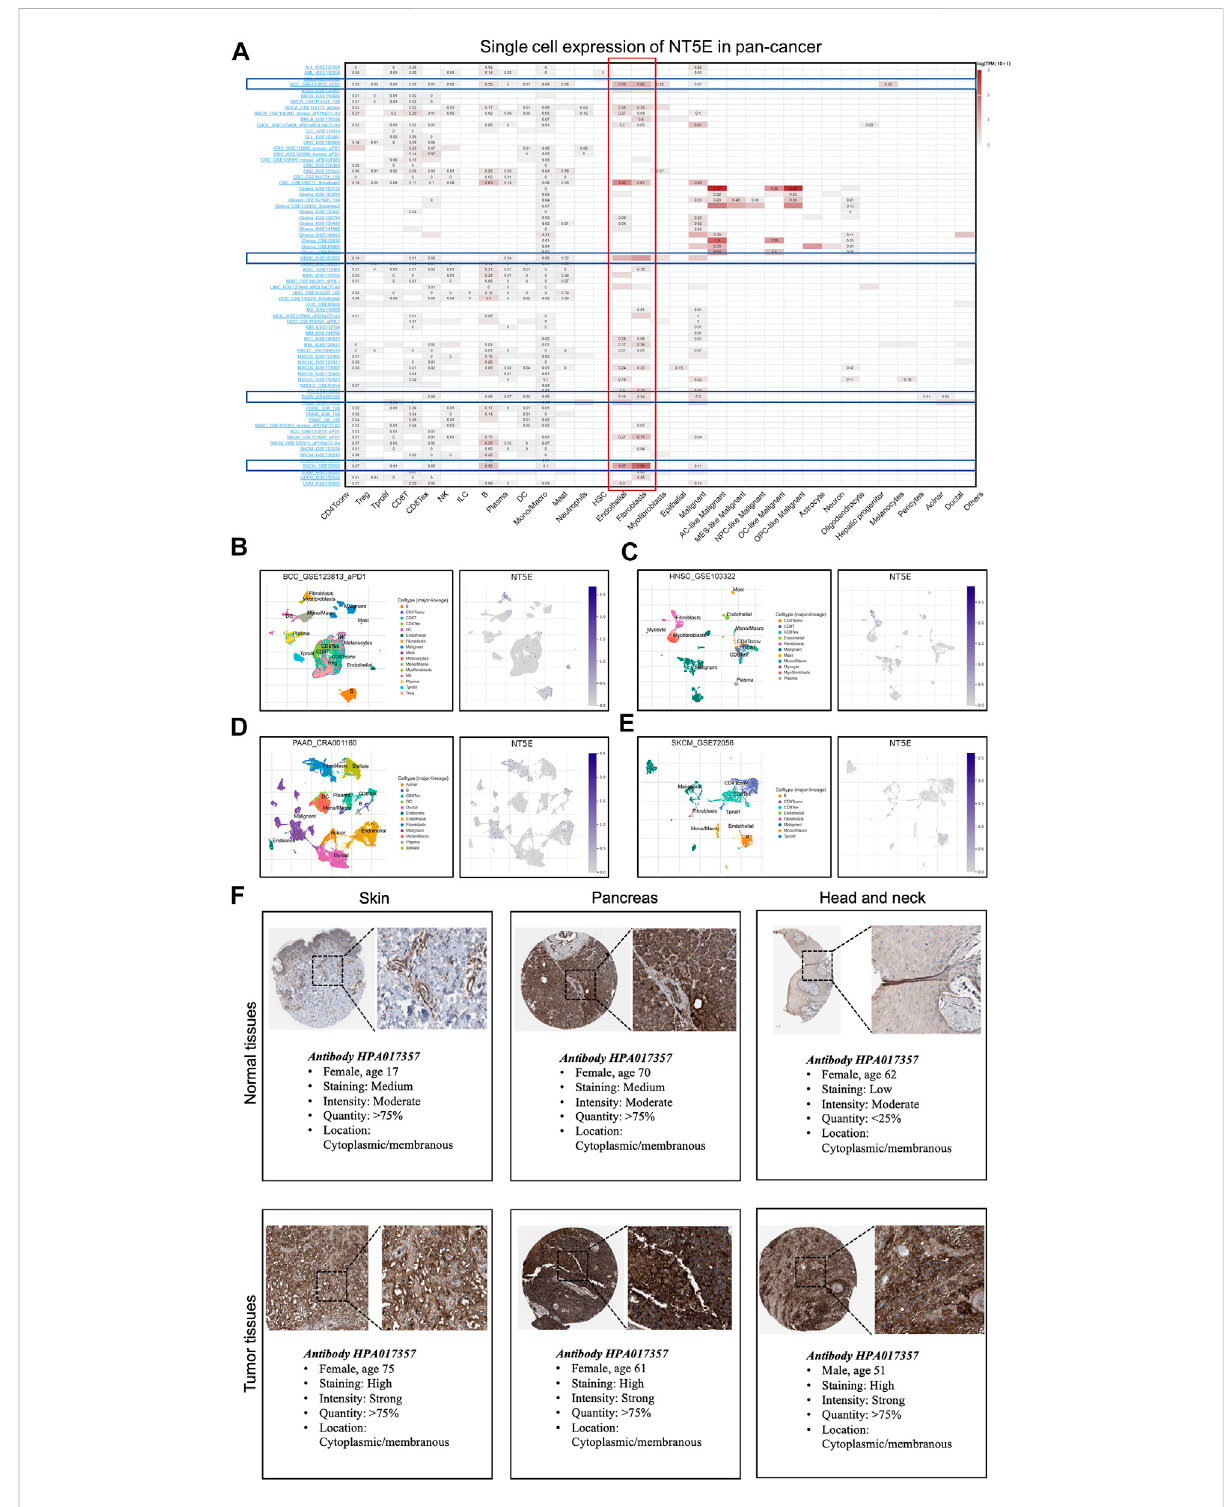
FIGURE 5 (A) SummaryofNT5Eexpressionof33celltypesin79singlecelldatabases. (B – E) Scatterplotshowed thedistributionsof10differentcelltypes (Left) and the NT5E expression levels (Right) of cells in the GSE123813_aPD1 BCC database (B) , GSE103322 HNSC database (C) , CRA001160 PAAD database (D) and GSE72056 SKCM database (E) . (F) Expression of the NT5E protein in several normal and tumor